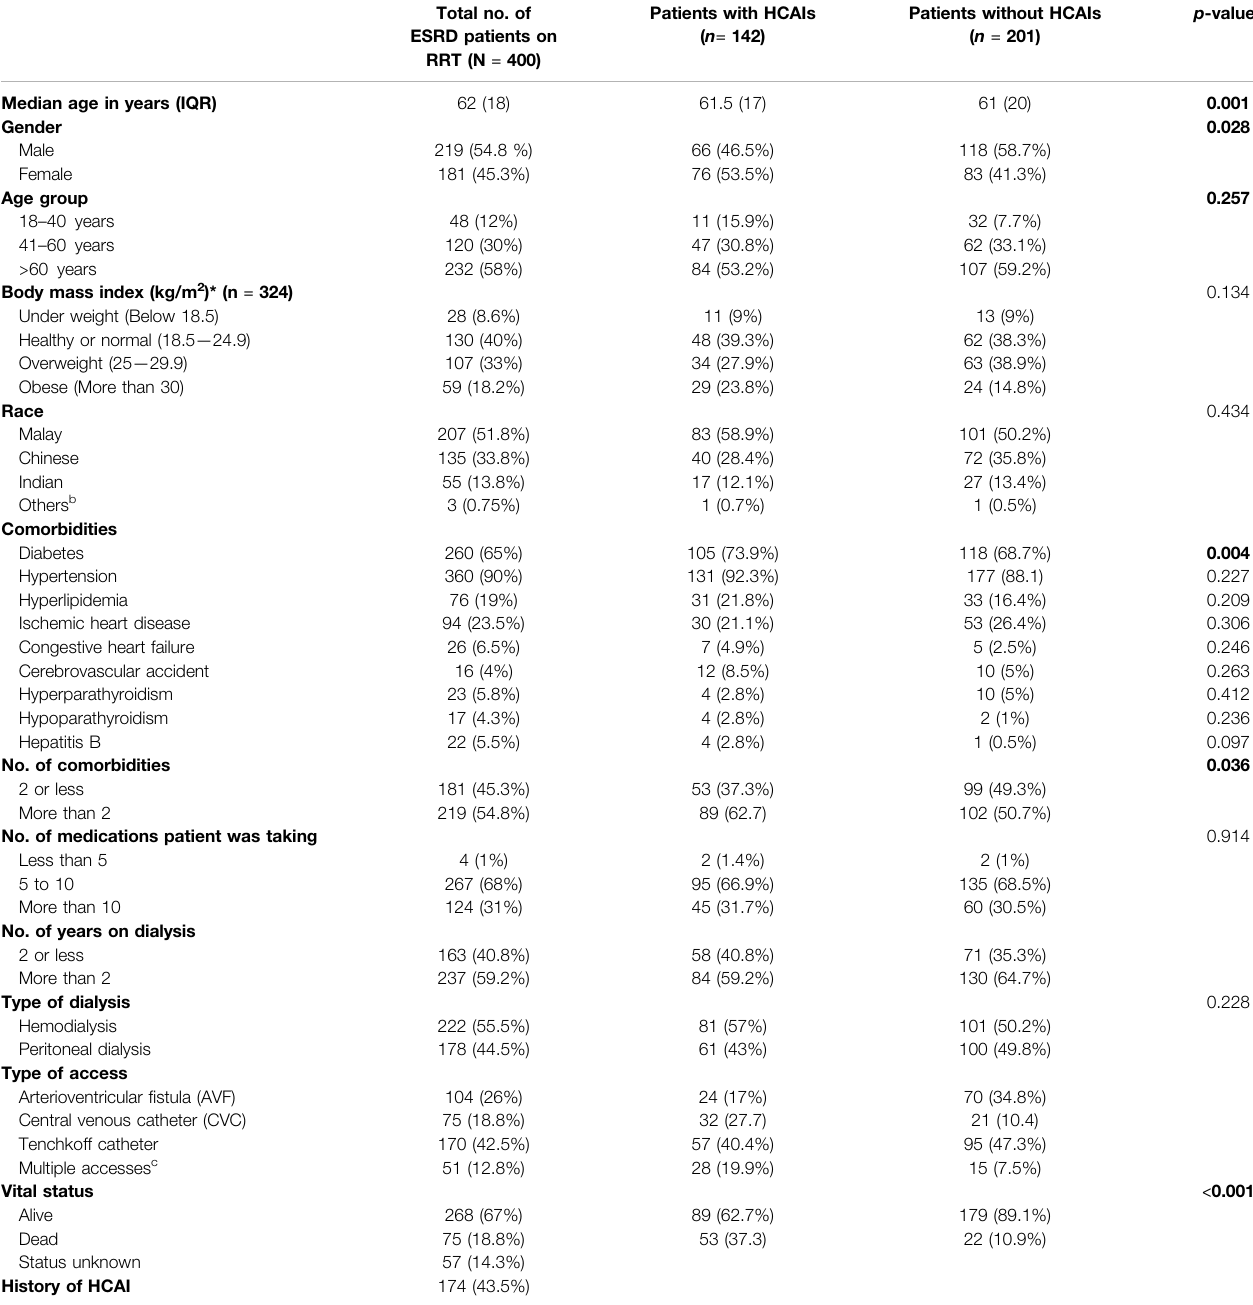
TABLE 1 | Matching criteria for survival analysis: Baseline characteristics of interest in patients with and without healthcare associated infections